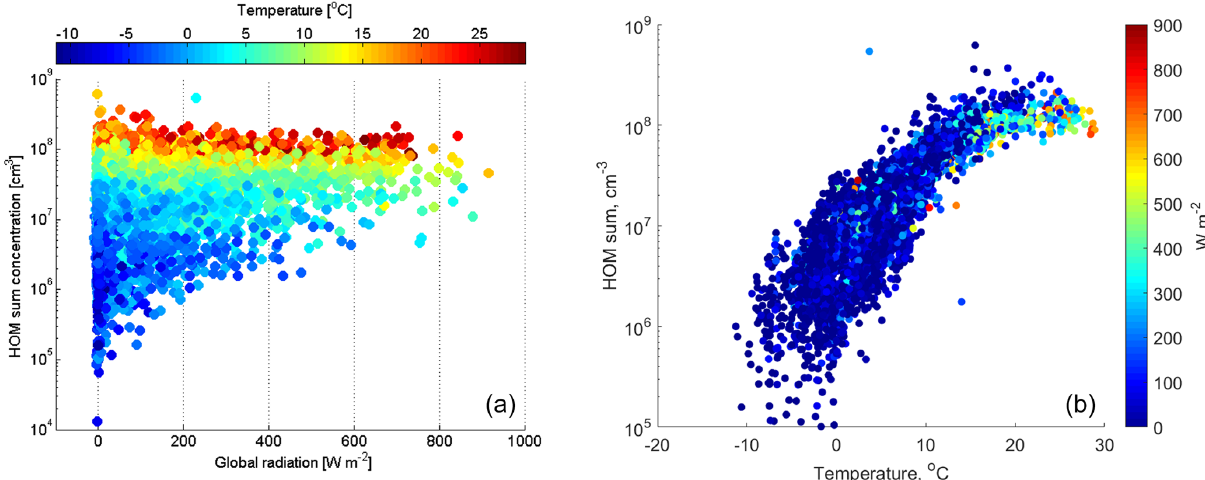
Figure 5. The HOM concentration (cm − 3 ) measured at SMEAR I (sum of the mass range from 300 to 600Th) as a function of (a) global radiation (Wm − 2 ) and (b) temperature ( ◦ C). The color bar represents air temperature in panel (a) and global radiation in panel (b) . The plot includes all data measured from April to October